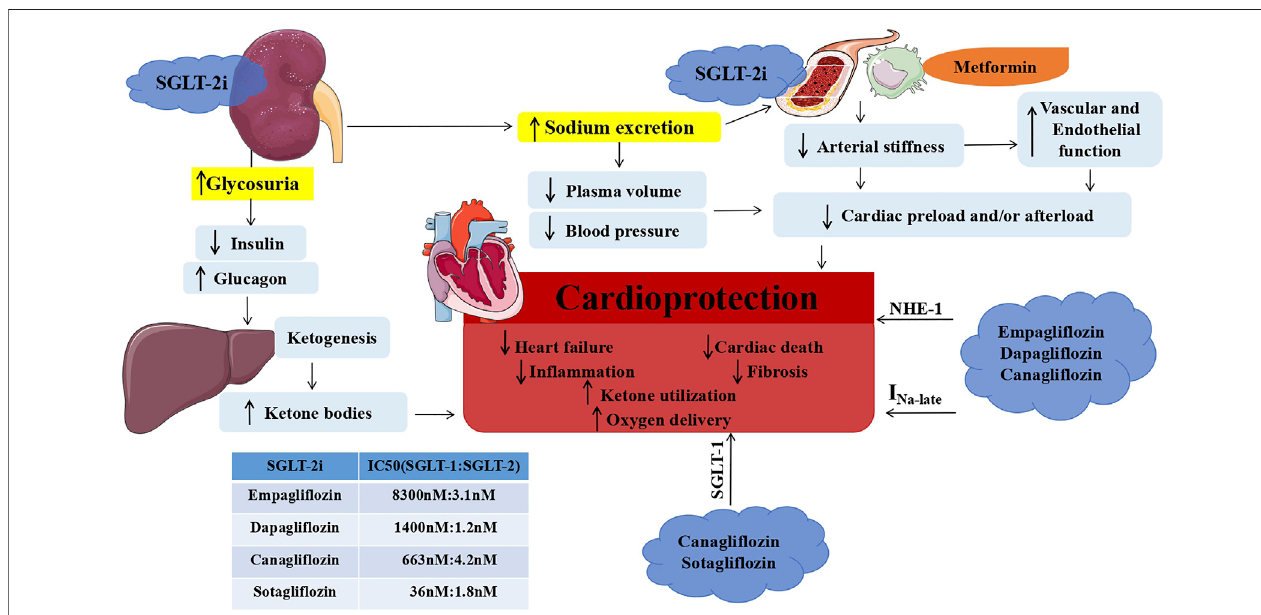
FIGURE 2 | The mechanism of SGLT-2i in cardioprotection. The comprehensive cardioprotective mechanism of SGLT-2i (including indirect and direct effects): SGLT-2i promotes urinary glucose excretion by inhibiting SGLT-2 on the kidneys, lowers insulin, increases glucagon, and then promotes the increase of ketone bodies through the ketogenic effect of the liver; In addition, SGLT-2i increases urinary sodium excretion, reduces blood volume and blood pressure, and reduces preload and afterload of the heart. These indirect effects on vascular cells (including endothelial cells and macrophages) are shown to reduce arterial stiffness and improve vascular and endothelial functions. Metformin can increase the bene fi cial effects of SGLT-2i on atherosclerosis. The direct effects of SGLT-2i include empagli fl ozin, dapagli fl ozin, and canagli fl ozin to inhibit NHE-1 and late Na ⁺ in cardiomyocytes. At the same time, canagli fl ozin inhibits cardiac SGLT-1. Sotagli fl ozin, a non-selective SGLT2i, is speculated to have this effect. The above-mentioned indirect and direct cardioprotective effects have improved heart function and decreased the rate of hospitalization for HF and cardiovascular mortality. Abbreviations: NHE1, Na + /H + exchanger 1; SGLT-1, sodium-glucose cotransporter 1; SGLT-2i, sodium-glucose cotransporter 2